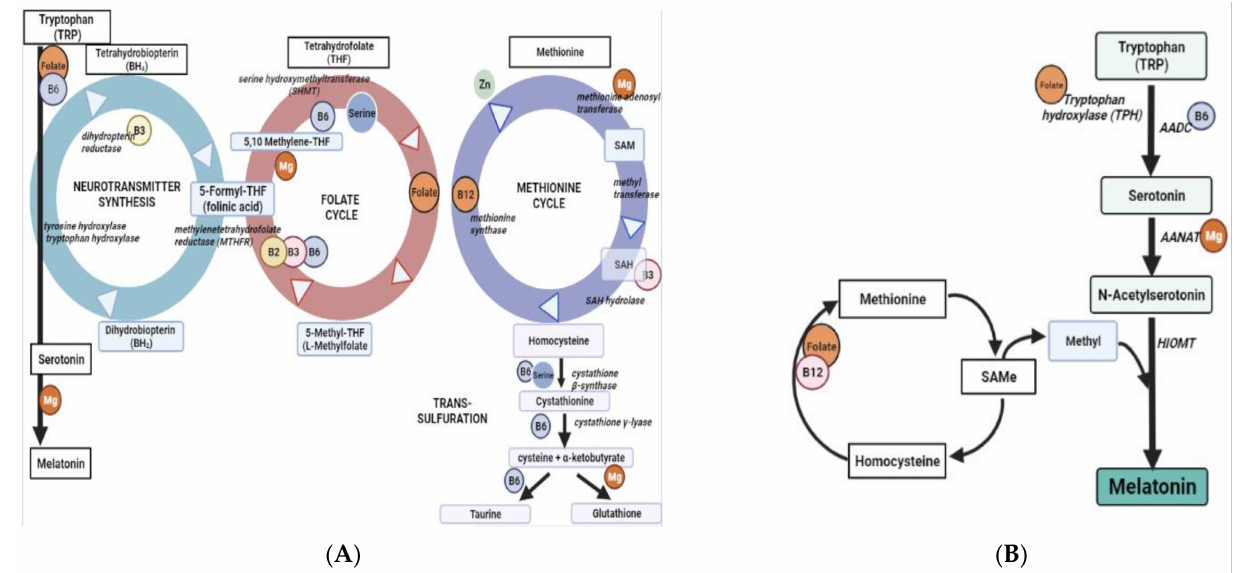
Figure 1. ( A ) Folate–methionine pathway and its interaction with neurotransmitter synthesis (mela- tonin) pathway, and ( B ) detailed interactive pathway of SAMe synthesis and donation of methyl group by SAMe for melatonin